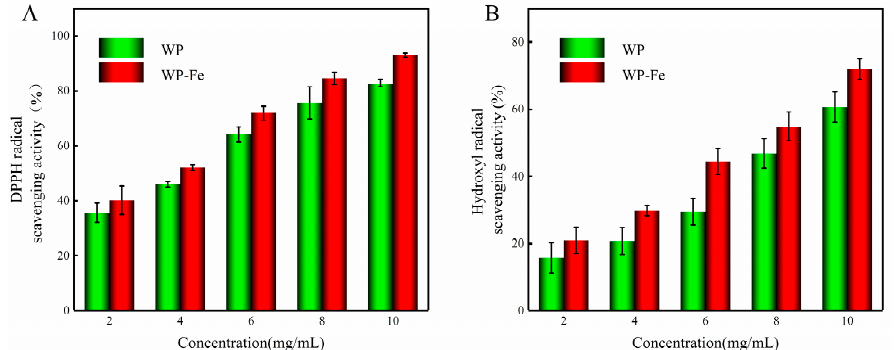
Figure 6. The antioxidant activities of the WP and WP–Fe. ( A ) DPPH radical scavenging activity and ( B ) hydroxyl radical scavenging activity.